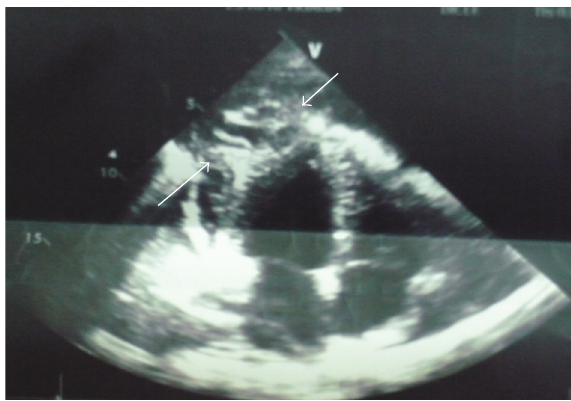
Figure 2: Preoperative echocardiography image. Lateral wall hydatid cyst image (arrows).